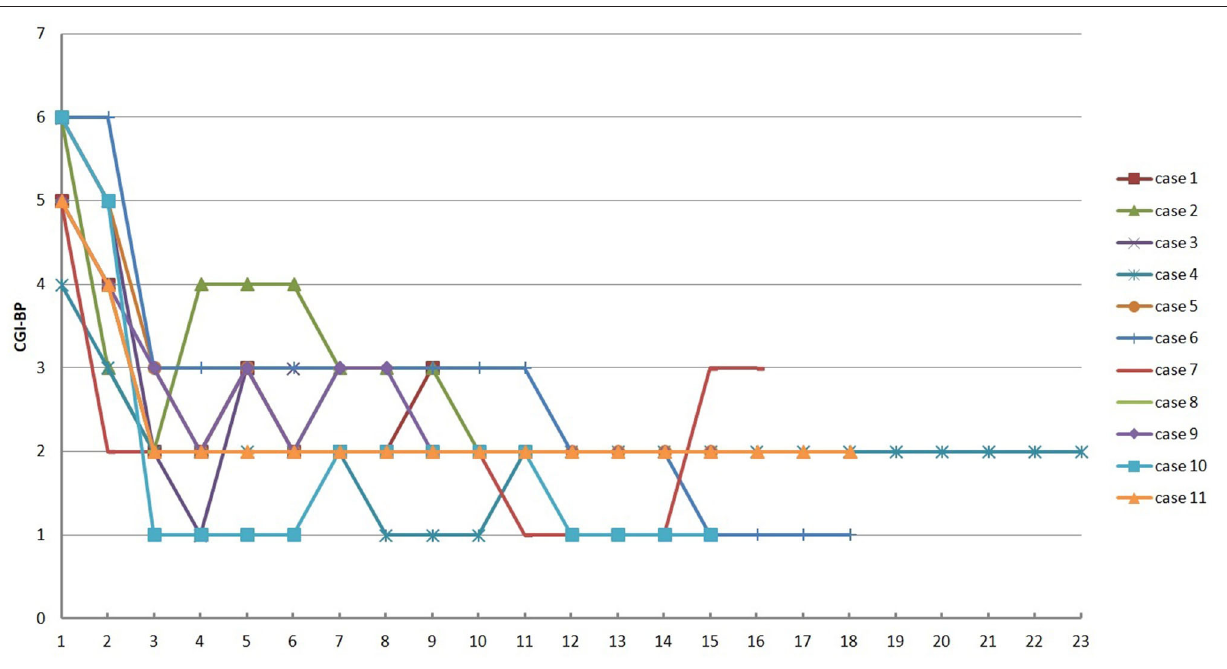
FIGURE 1 | The distribution of CGI-BP of all the participants over each injection of